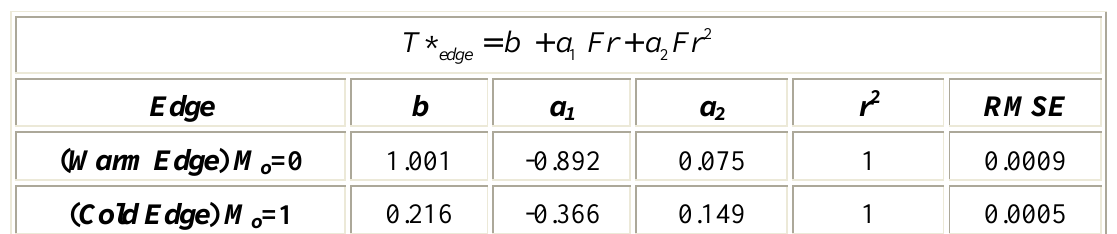
Table 2. Coefficients for the polynomial relating the temperature along the warm edge and Fr as specified in Equation